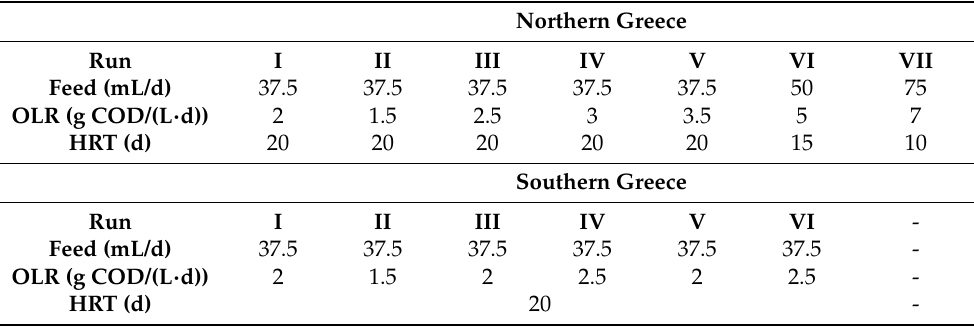
Table 1. Methanogenic bioreactors’ operating conditions during the valorization of Northern Greece and Southern Greece fall/winter